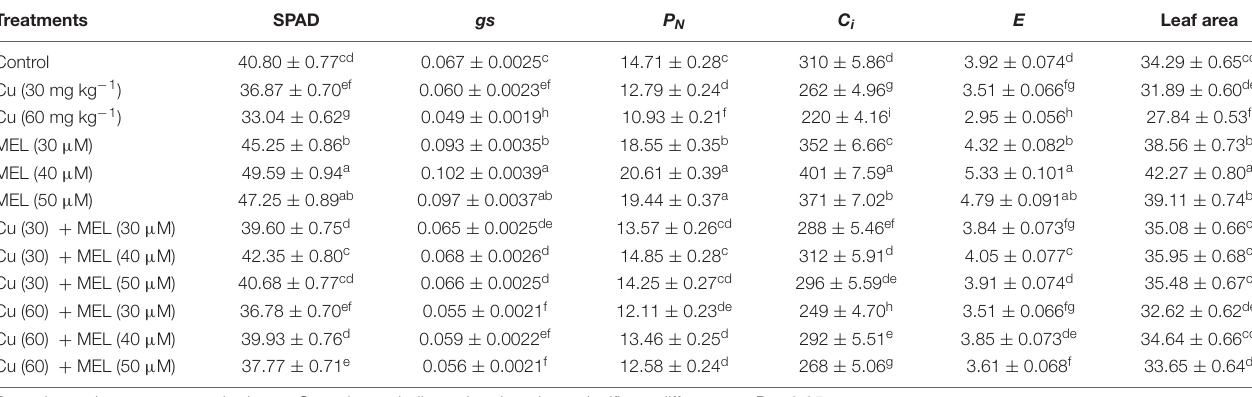
TABLE 2 | Effect of different levels of soil applied Cu (0, 30, or 60 mg kg − 1 ) and/or MEL (30, 40, or 50 µ M) on SPAD chlorophyll values, stomatal conductance ( g s ) (mol m − 2 s − 1 ), net photosynthetic rate ( P N ) (M CO 2 m − 2 s − 1 ), internal CO 2 concentration ( C i ) (ppm), transpiration rate ( E ) (mol m − 2 s − 1 ), and leaf area (cm 2 ) of Brassica juncea at 45 DAS.